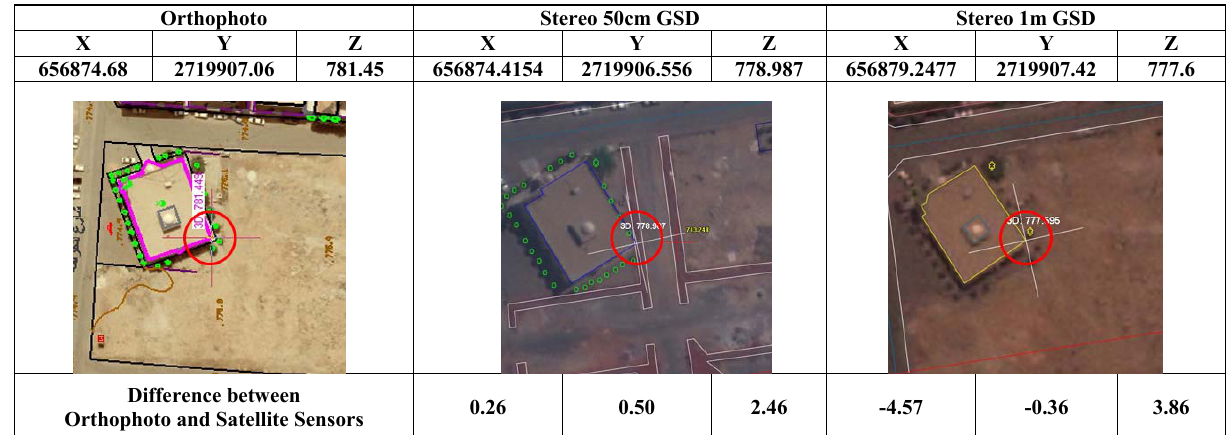
Table 1g. Showing the example of mosque building which is recognizable on 50cm and 1m GSD Stereo Satellite Imagery but 10cm GSD orthophoto have more details of the mosque building